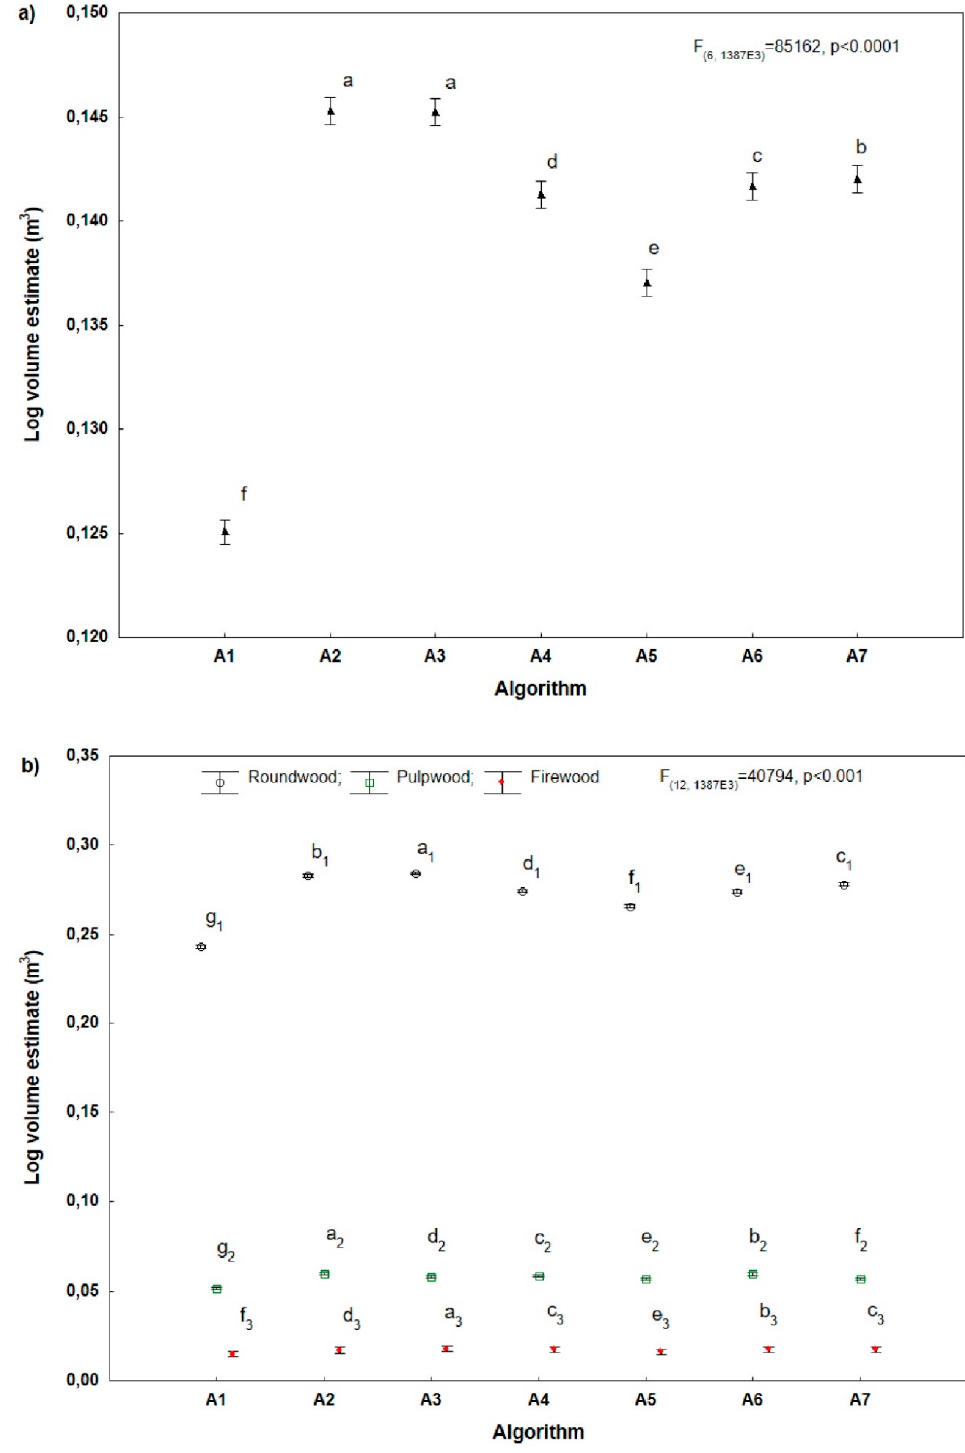
Figure 2. Di ff erences in mean volume estimates per log by di ff erent algorithms ( a ) of all logs together, ( b ) according to assortments. Di ff erent letters indicate significant di ff erences revealed by post-hoc Tukey HSD tests ( α = 0.05); assortments were tested separately. The error bars indicate a 0.95 confidence interval. There were no significant di ff erences only between Algorithms A2 and A3 in the group of all logs together (a-a) and between Algorithms A4 and A7 in the firewood assortment (c 3 -c 3 ).